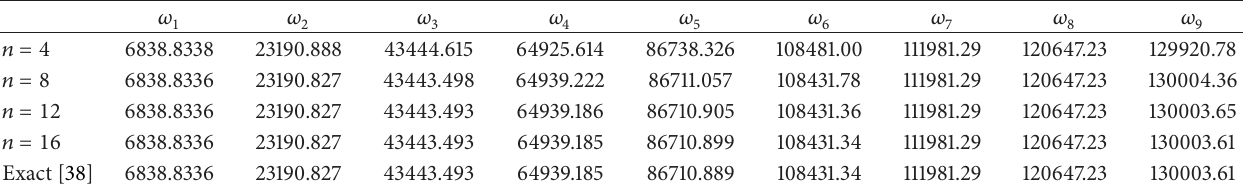
Table 1: Free vibration frequencies for simple-simple Timoshenko beam.